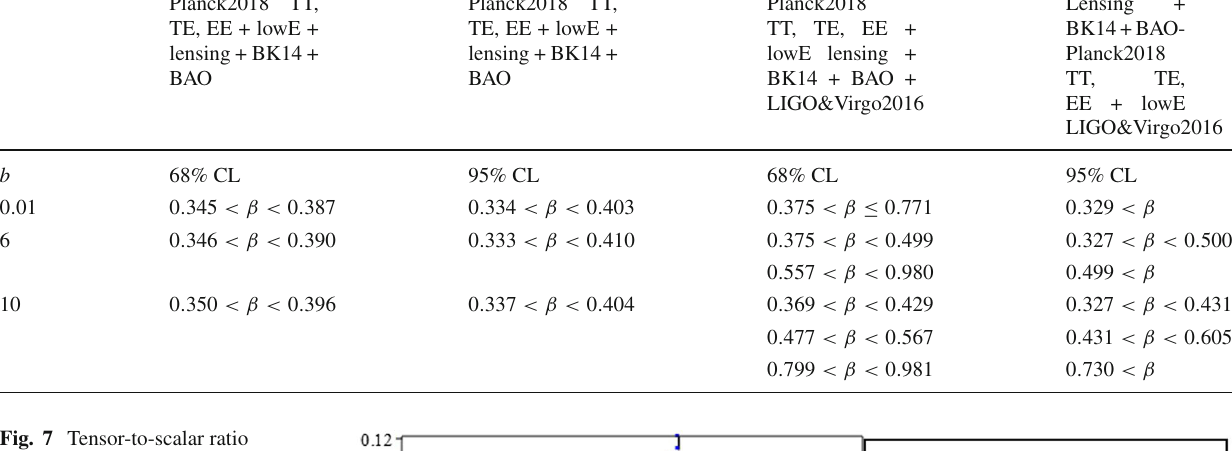
Fig. 7 Tensor-to-scalar ratio versus the tensor spectral index for the intermediate MDBI model. To plot this figure, we have adopted 0 < β < 1 and N = 60